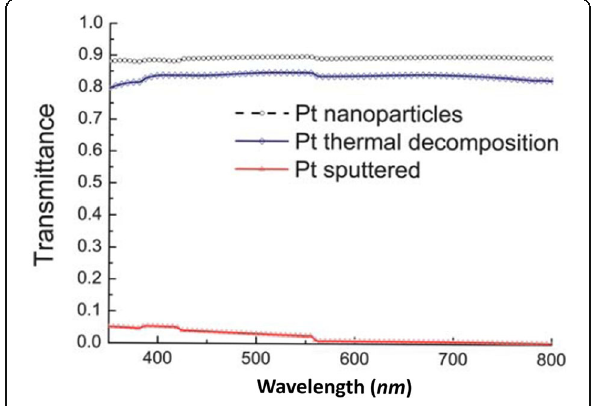
Fig. 5 Optical transmittance of platinum-based films (Pt nanoparticles, Pt thermal decomposition, Pt sputtered) deposited onto FTO glass [82]